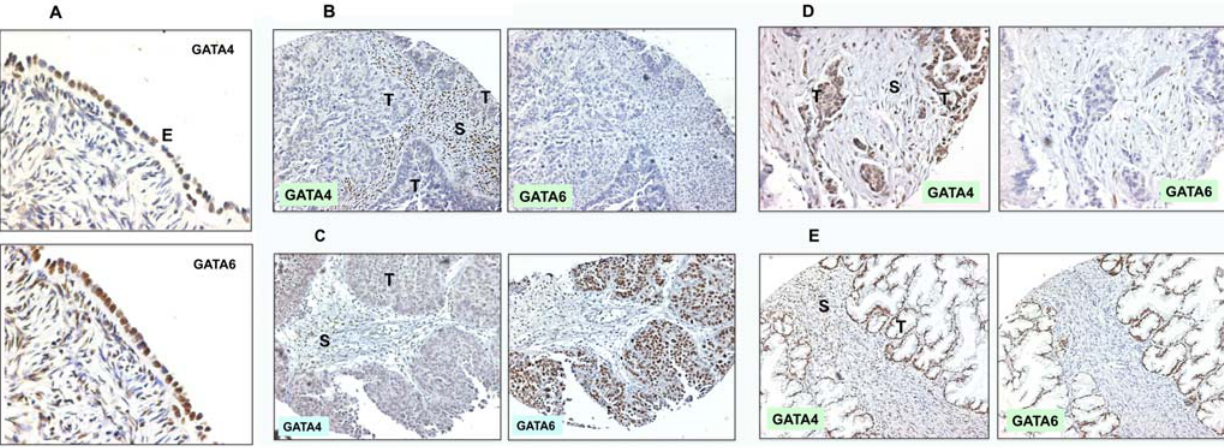
Figure 1. Immunostaining of GATA4 and GATA6 in ovarian cancer histological subtypes. Immunostainings of GATA4 and GATA6 were performed in 111 ovarian carcinomas including the 4 histological subtypes. The results are summarized in Table 1. A . Normal ovarian surface epithelial cells are positive for both GATA4 and GATA6 in the nucleus. 200 6 magnification. B . An example of both GATA4- and GATA6-negative serous carcinoma. 40 6 magnification. C . An example of GATA4-negative and GATA6-positive serous carcinoma. 40 6 magnification. D . An example of GATA4-positive and GATA6-negative serous carcinoma. 40 6 magnification. E . An example of both GATA4- and GATA6-positive mucinous carcinoma. 40 6 magnification. E , epithelium; T , tumor; S , stroma.